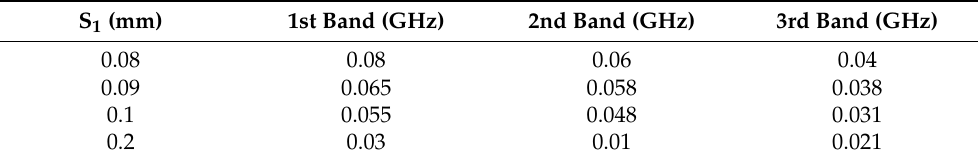
Figure 18. Coupling phenomena with respect to the parameter S.